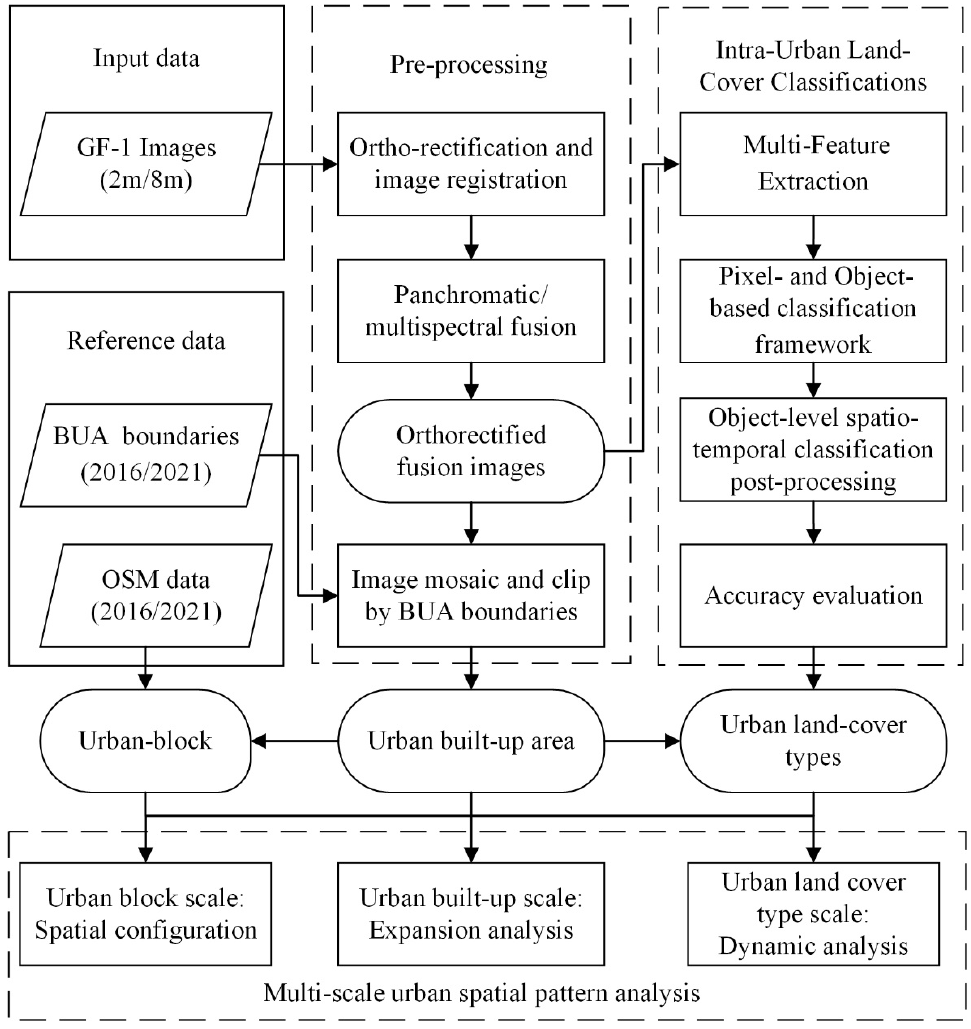
Figure 2. Workflow of the procedure of the proposed urban multi-scale landscape pattern monitoring method.